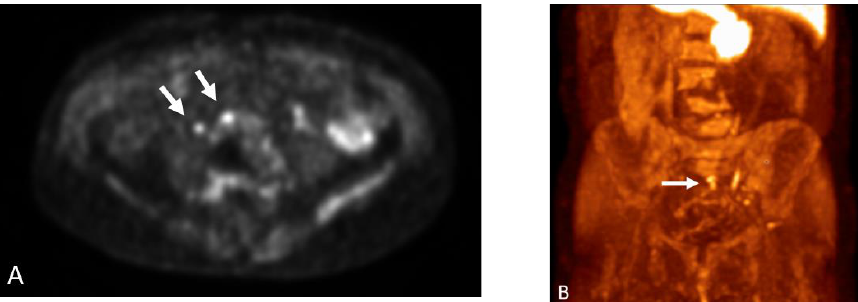
Figure 6. Seventy-two-year-old male with prostate cancer, status post-prostatectomy, now presenting with rising PSA levels. Axumin PET ( A ) and MIP ( B ) images show Axumin uptake within two right peri-aortic lymph nodes, suggestive of nodal disease. Also note that the abnormal uptake in the bone marrow, secondary to treatment-related effects.